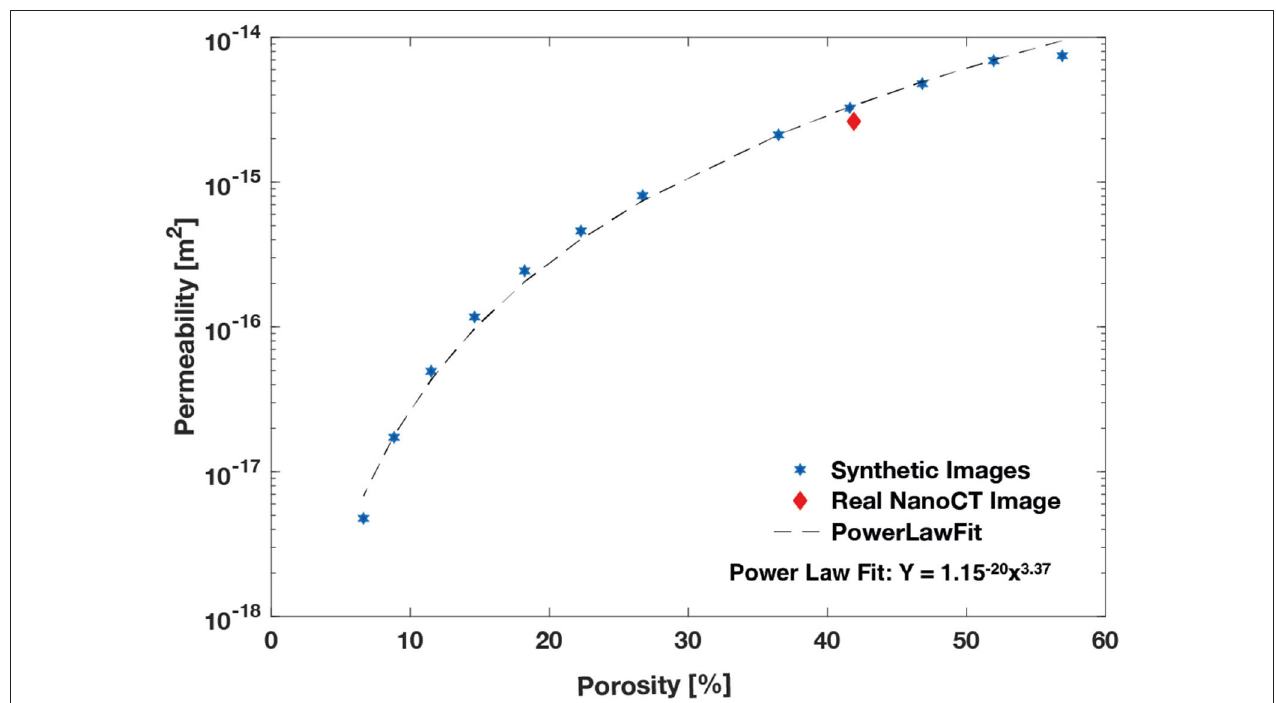
FIGURE 7 | The synthetic porosity–permeability relationship (blue stars), with the power law fit of Y = 10 − 20 × 3.72 (black dashes) and the real image porosity and permeability value (red diamond).